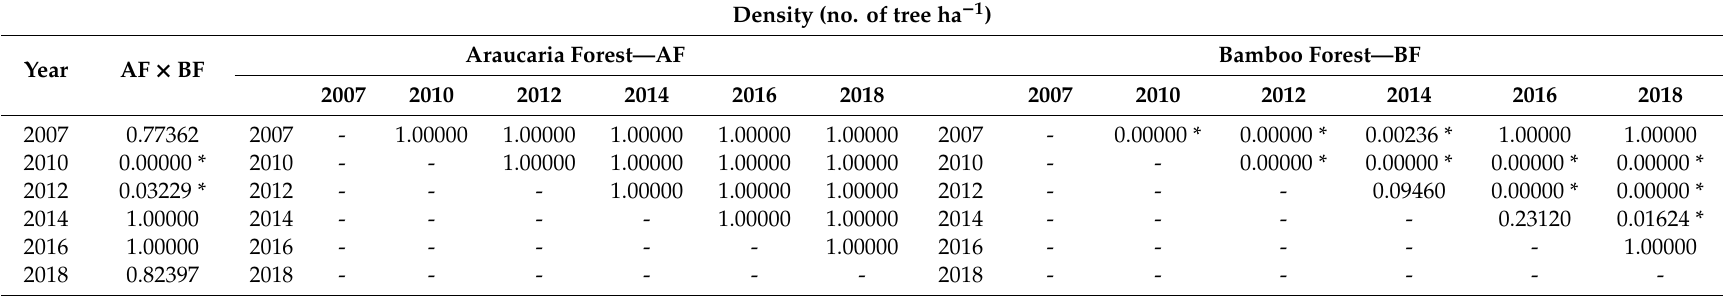
Table A2. Results for statistical significance ( p -values) using mixed model statistics for comparisons between Araucaria Forest (AF) and Bamboo Forest (BF) during the 2007–2018 period and between years for AF and BF separately for density (no. of tree.ha − 1 ), basal area (m 2 .ha − 1 ), mean height (m) and mean diameter at breast height—DBH (cm). * denote significant di ff erence at α =